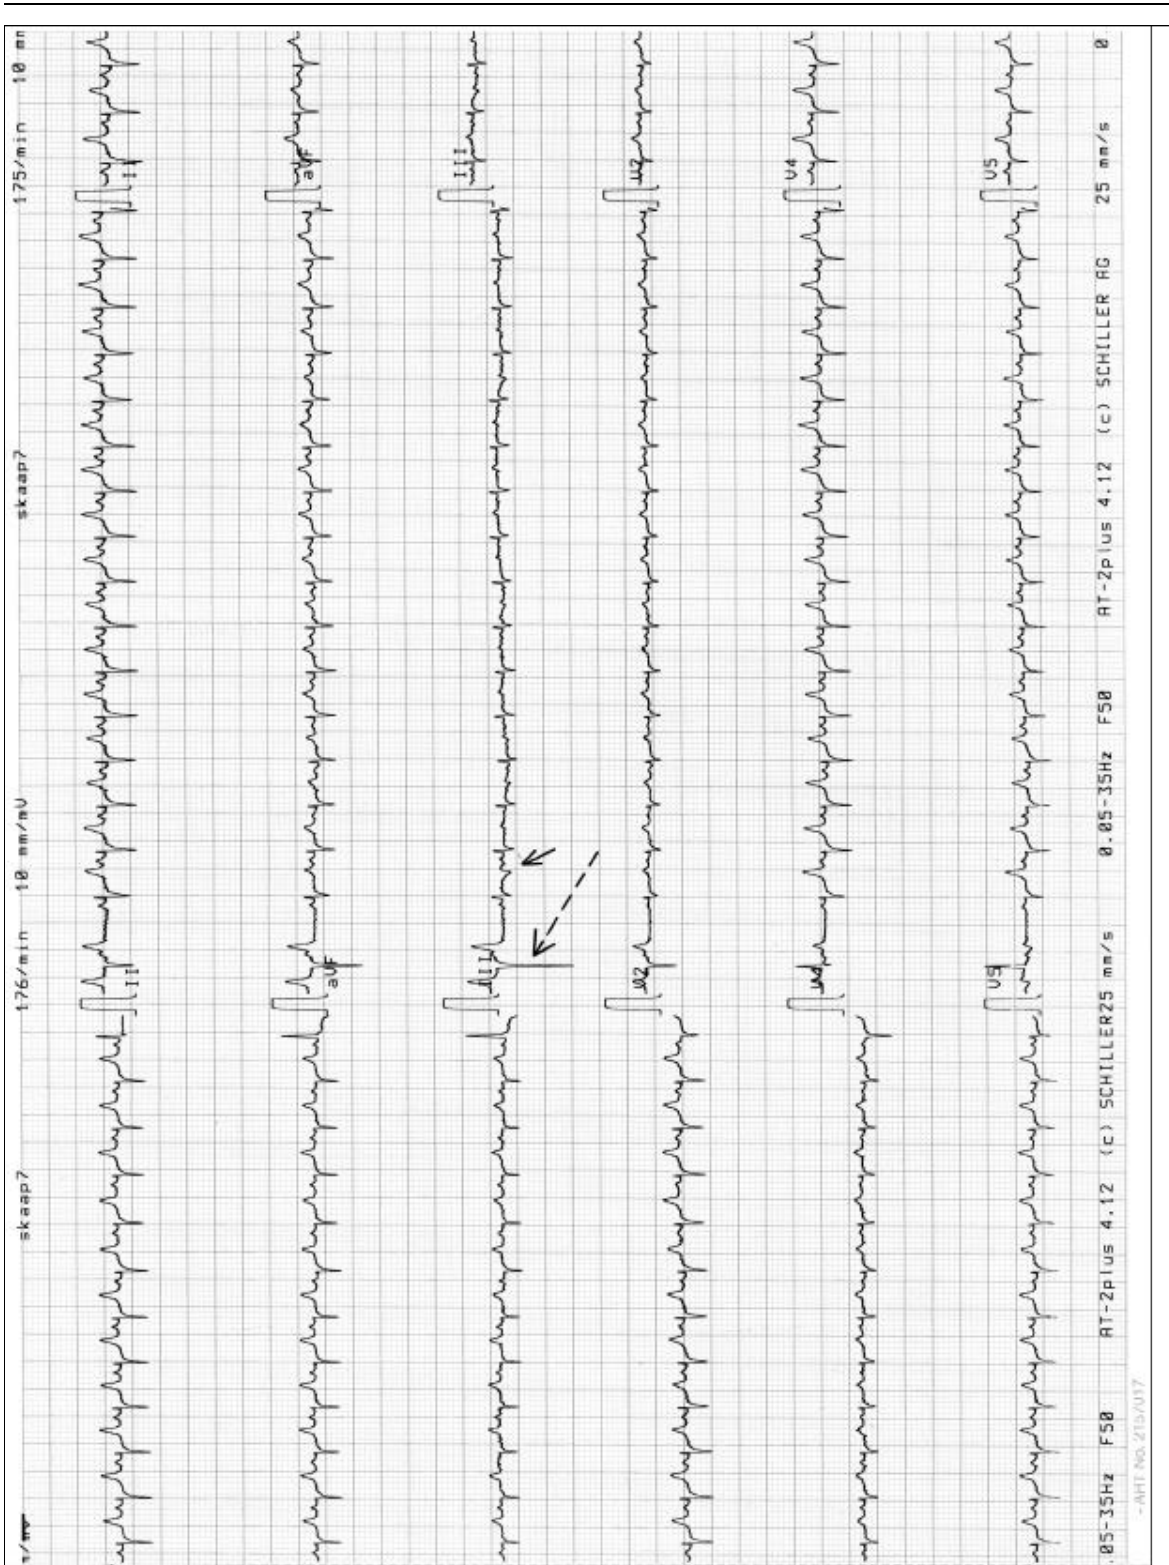
FIG. 3 Example 3—cardiac memory, demonstrated in lead